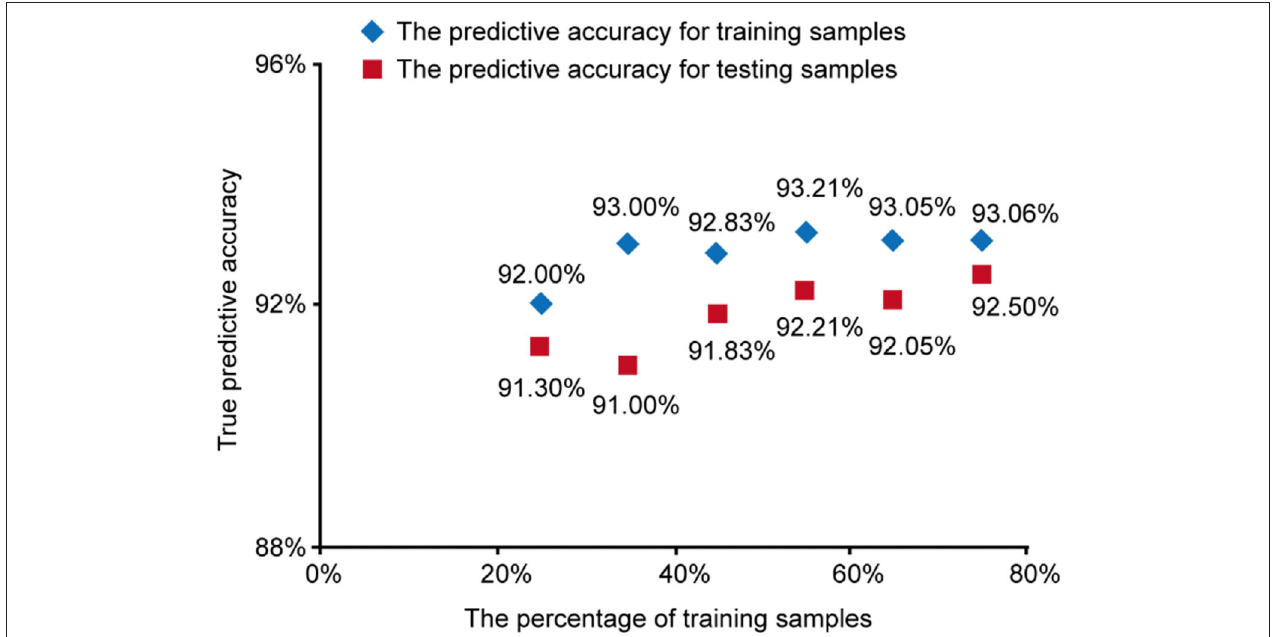
FIGURE 3 | The predictive accuracy for training samples and testing samples vs. the percentage of training